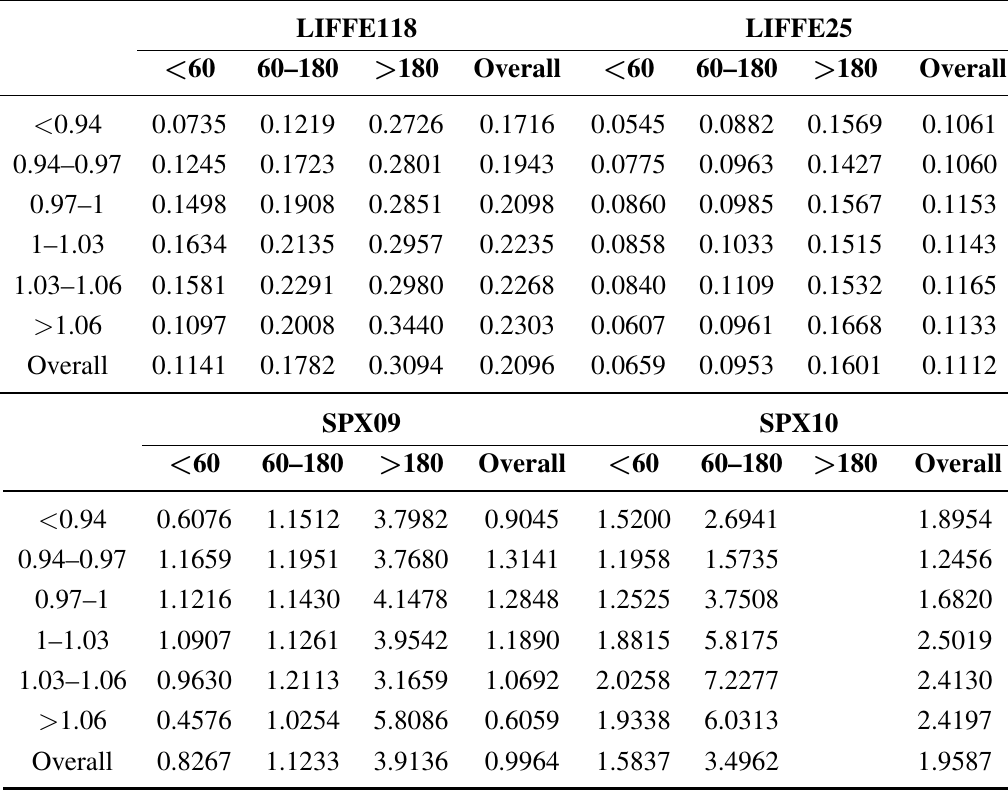
Table 6. For each of four data sets (in boldface), we present in-sample pricing errors for the robust MT method that utilizes the pseudo-Huber loss function. The out-of-sample pricing errors corresponding to these tables are given in Table 7 in the manuscript. This table corresponds to the discussion of in-sample errors in Section